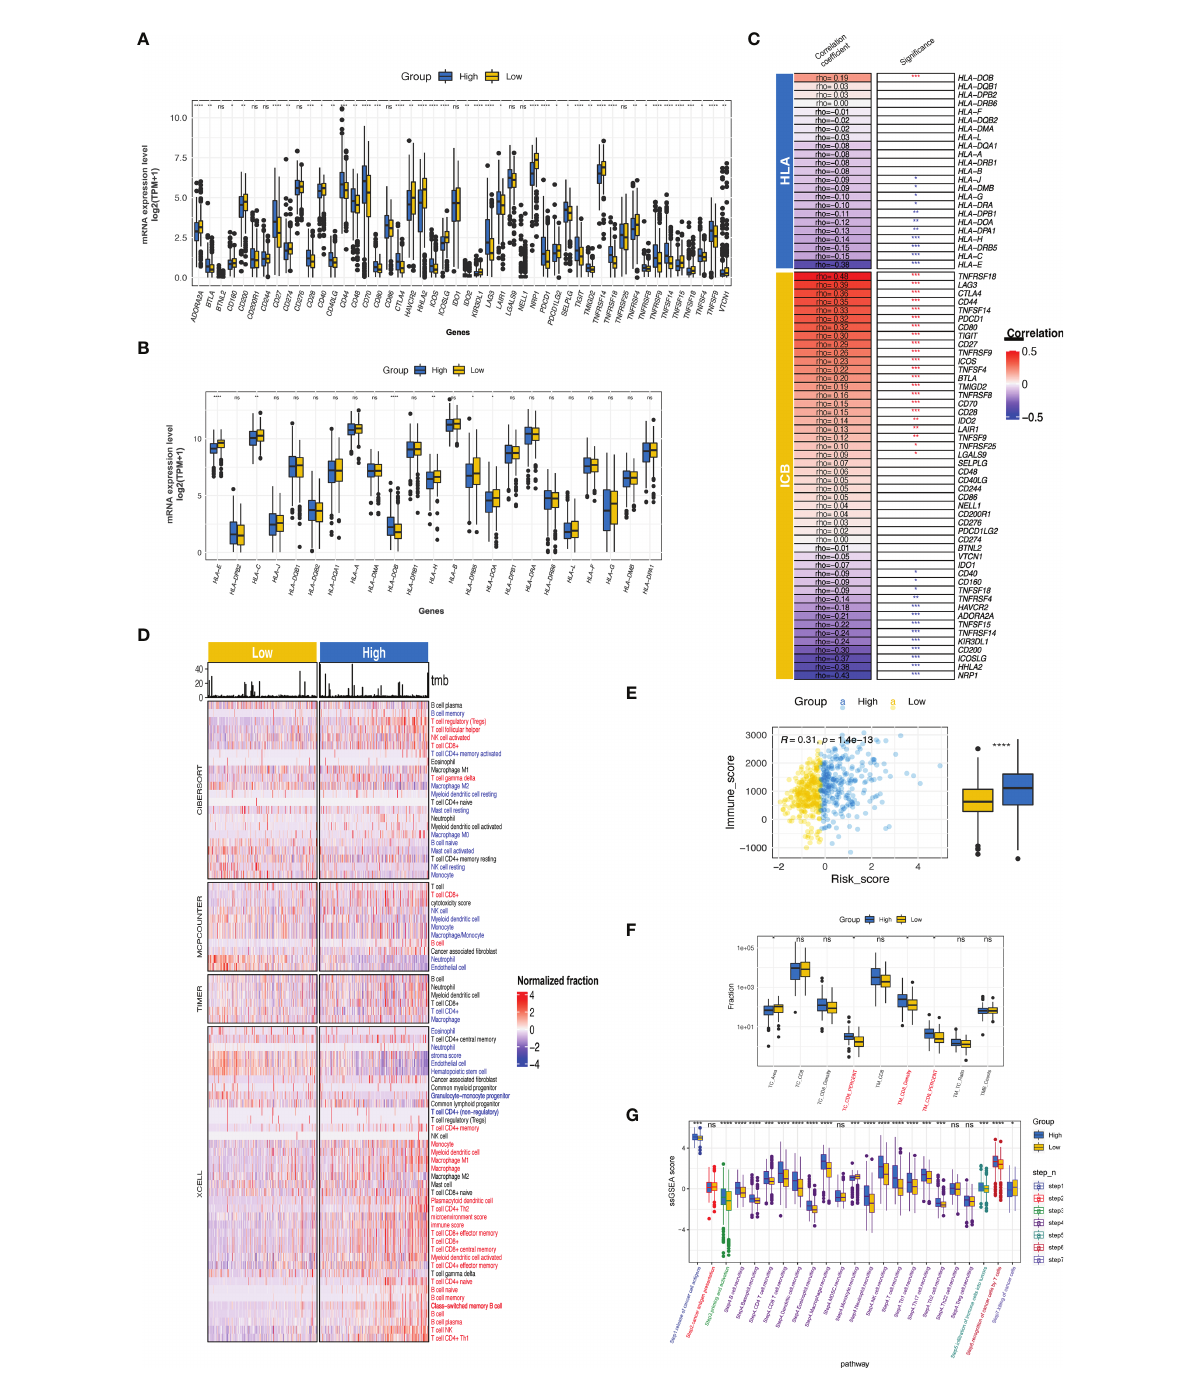
FIGURE 9 Immune phenotypes and tumor microenvironment relatedto CTR score. (A) Comparisonof the expressionlevel ofimmune checkpoints between highand low claudin-TME related (CTR) groups. (B) Analysis of the differencein the expression level of human leukocyte antigen (HLA) familygenes between high and low CTR groups. (C) Correlationbetween CTR scoreand the expressionlevel of immune checkpoints or HLA family genes. The asterisksindicate a signi fi cant statistical p value,and those colored with red and blue indicate positive and negative correlation with CTR score, respectively. (D) Comprehensive analysisof the difference in the tumor-in fi ltrated immune cells (TIICs) between highand low CTR groups using multiplealgorithms(CIBERSOFT, MCPCOUNTER,TIMER, andXCELL).TIICs with blue color weresigni fi cantly moreenriched in the low CTR group; whereas, those with red color weremoreenriched in the high CTR group (p< 0.05). (E) Correlation between CTR score and immune score. (F) Difference in the CD8 + T cells between high and low CTR groups in an integrationcohort with CheckMate-009,010 and 025 cohorts. (G) Differences in the activity of seven steps ofcancer-immunity cycle between two CTR groups. *p< 0.05, **p< 0.01,***p< 0.001, ****p< 0.0001,ns, not signi fi cant; HLA,human leukocyte antigen; TC,tumor center;TM,tumor margin; TPM, transcript per million; ssGSEA, single-samplegene set enrichment